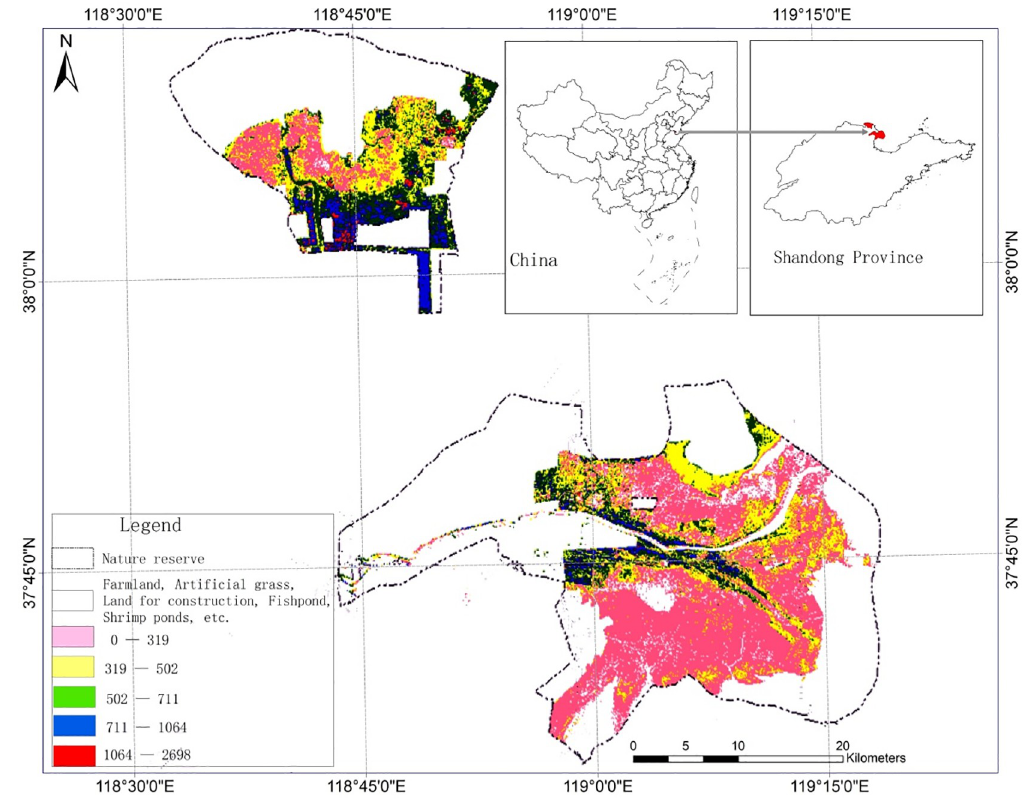
Fig 2. Spatial distribution of biomass density in the Yellow River Delta Nature